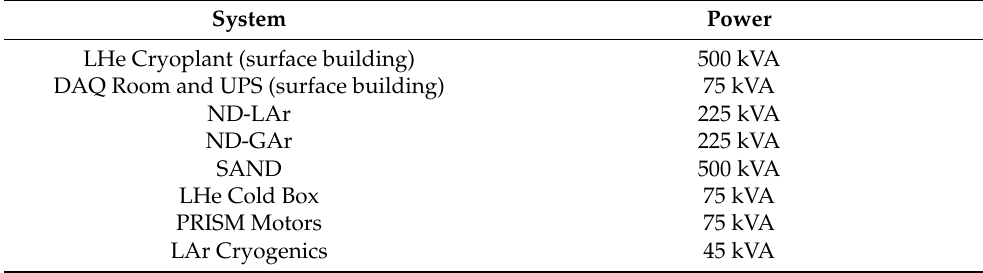
Table 28. Near Detector Electrical Power